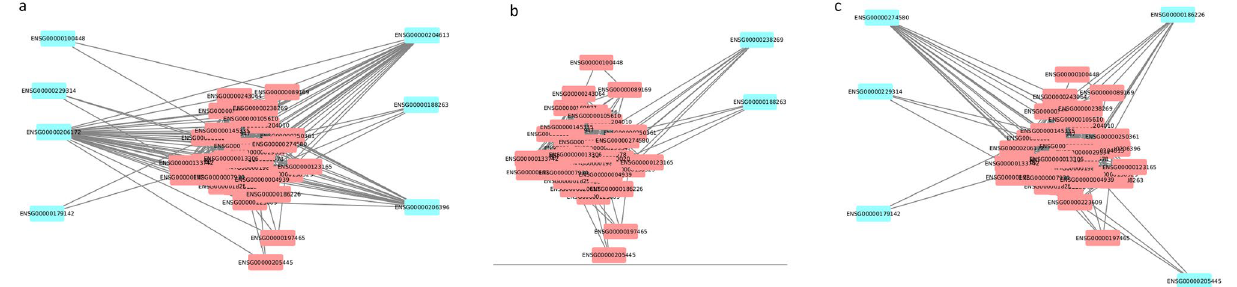
Figure 4. Likely differentially expressing genes (LDEGs) identified in Module 53 in ( a ) moderate versus healthy, ( b ) severe versus healthy, and ( c ) extremely severe (ICU) versus healthy. LDEGs are represented in blue